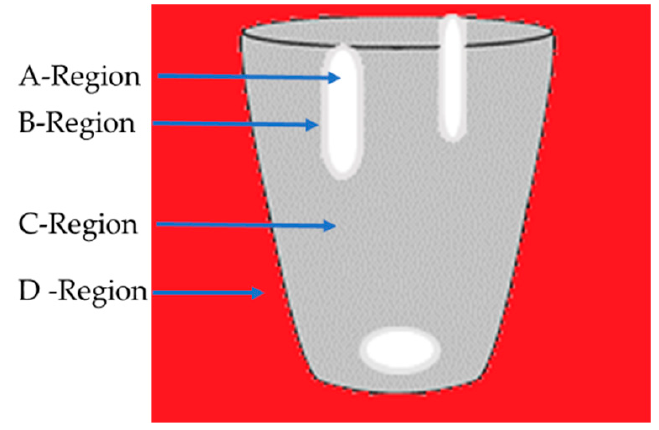
Figure 7. Classification of regions of MSPLFI object imagery: (A) specular reflection; (B) mixed specular and diffuse reflections; (C) diffuse reflection; (D) background. Algorithm 2. SRI in Transparent Object